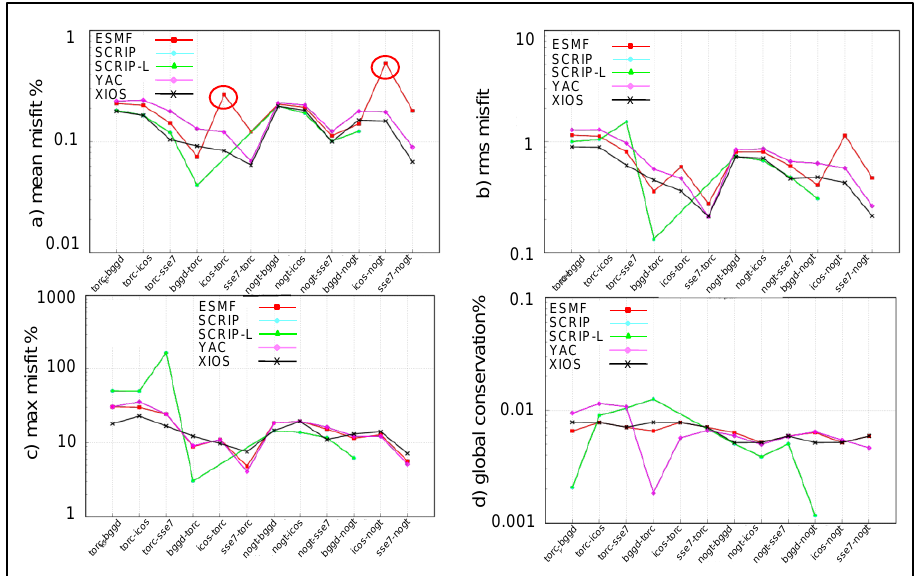
Figure 14. ( a ) Mean, ( b ) rms, ( c ) maximum misfit, and ( d ) source global conservation for the different pairs of grids for the harmonic function for second-order conservative remapping with FRACAREA normalisation. The red circles identify anomalous regriddings for ESMF when the source grid is the icosahedral one ( icos ) detailed in the text.